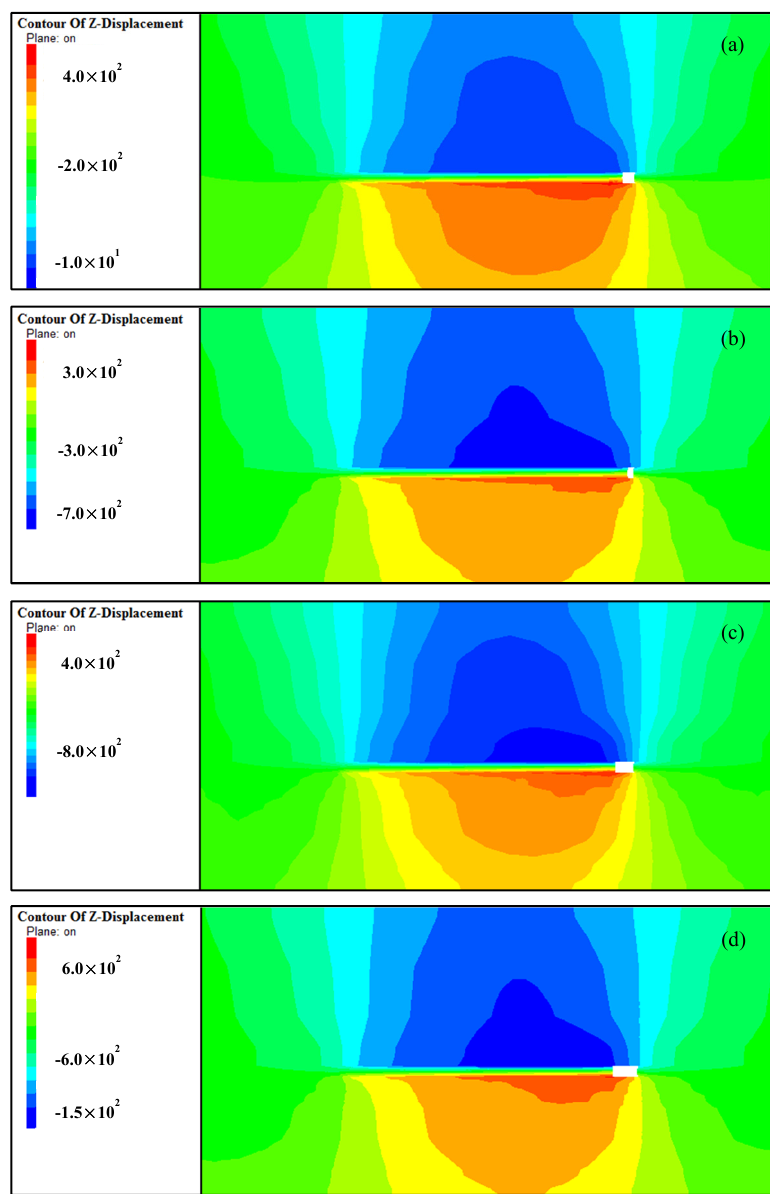
Figure 10. Floor displacement under different filling steps of paste-filling working face. ( a ) Filling step distance 1 m, ( b ) Filling step distance 2 m, ( c ) Filling step distance 3 m, ( d ) Filling step distance 4 m.